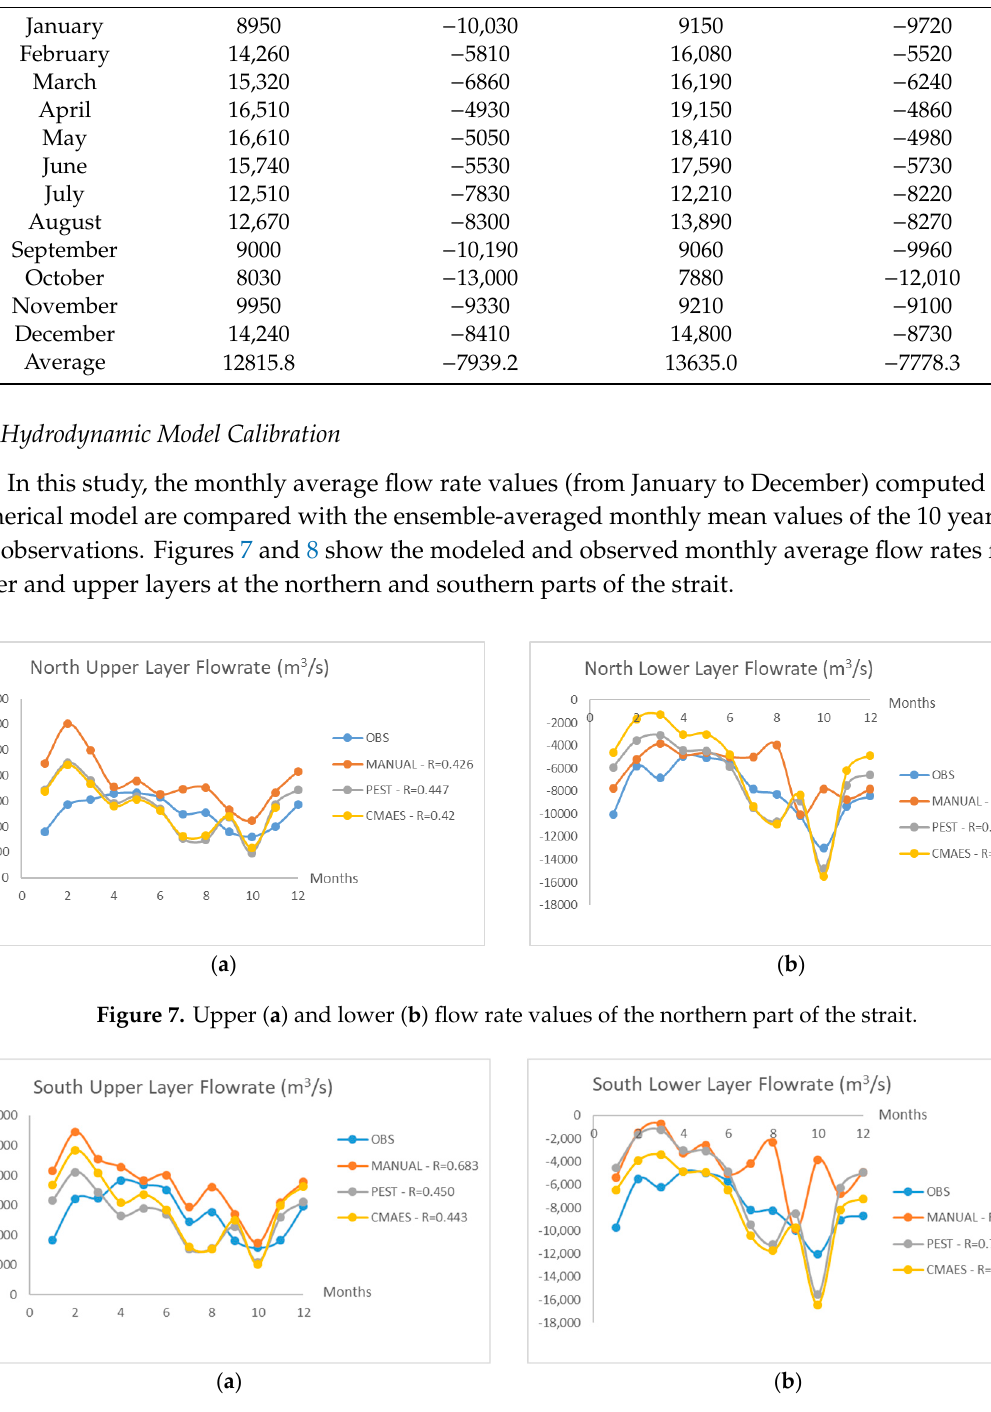
Table 3. The average of 10 years of in situ flow rate values measured in the north and south of the strait [21].